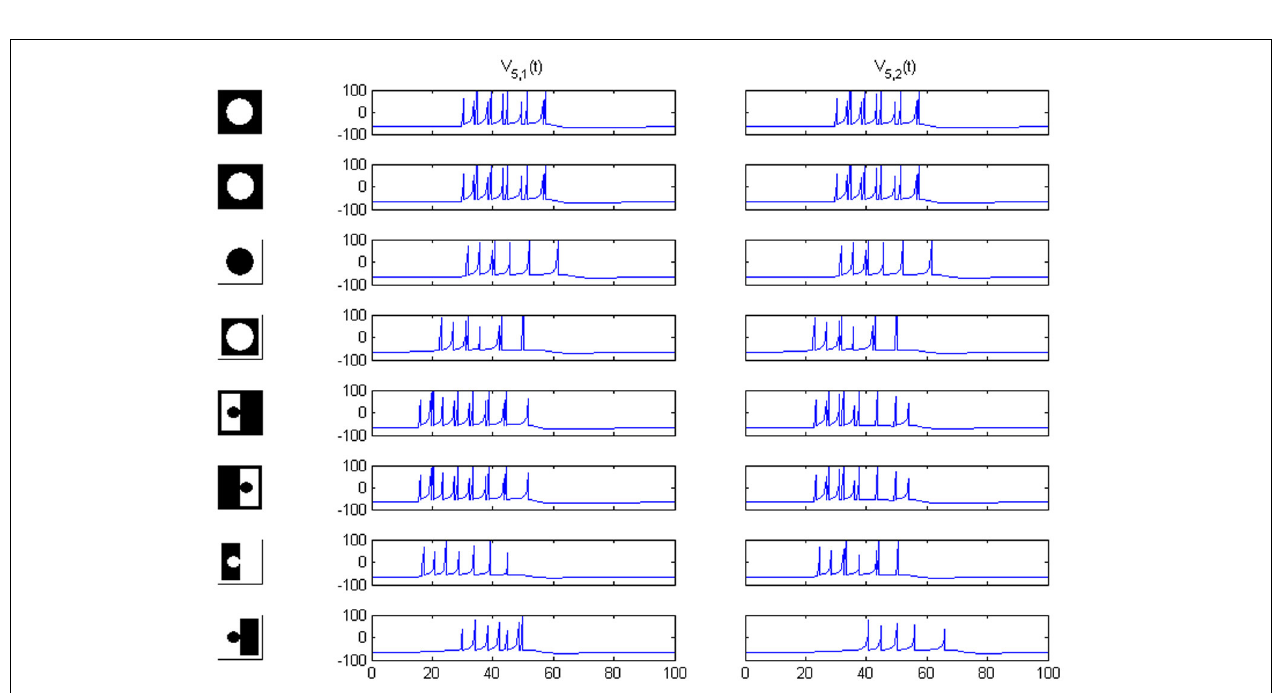
FIGURE 11 | Rows 1–4: network responses on area 5 for a circle disconnected from a hypothetical frame. Rows 5–8: responses for a circle connected to the frame by the mid-points of opposed sides (preserving the border length, as required).